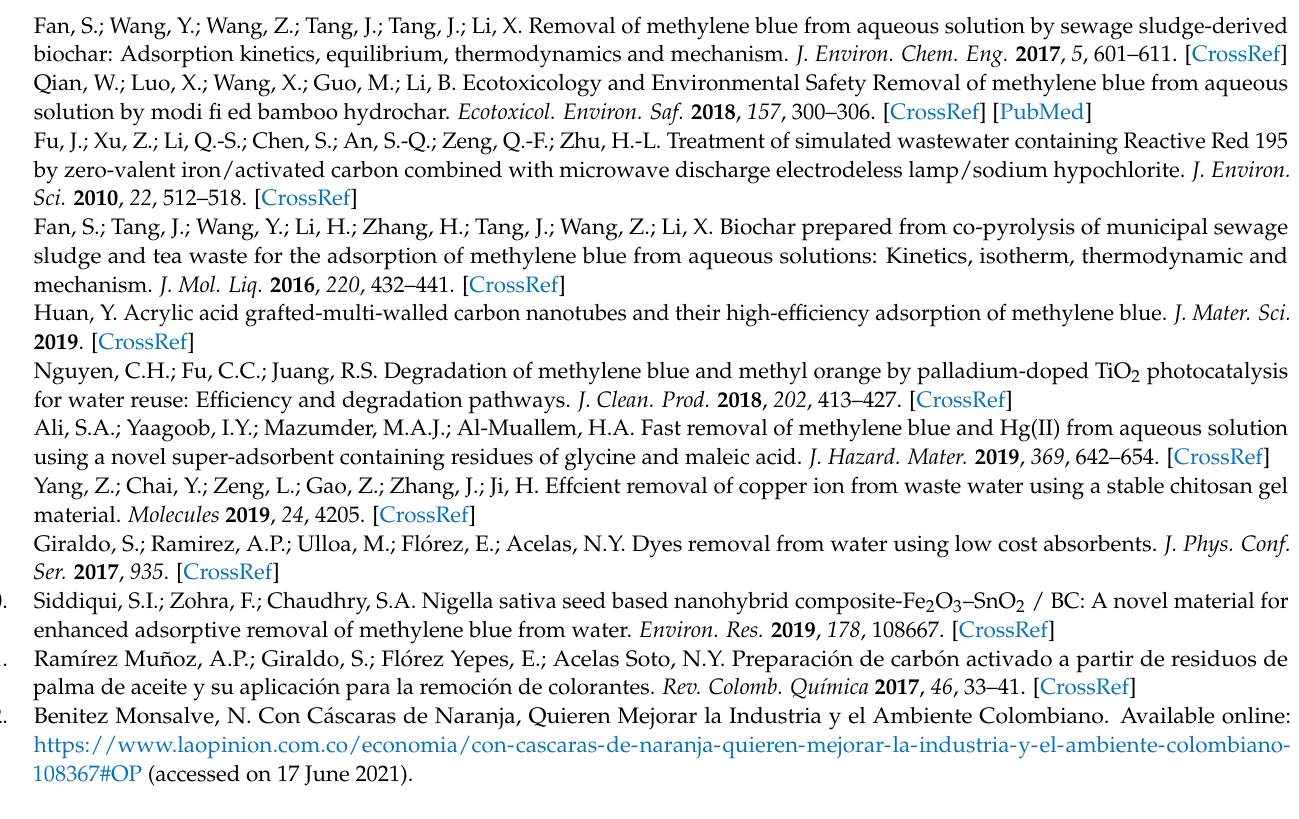
Supplementary Materials: The following are available online. Figure S1 FTIR spectra of calcined materials at different temperatures. Figure S2 pH PZC of adsorbent materials. A: OP; B: AZOP-550; C: AHOP. Figure S3 Graphs of the adsorbents (OP, AHOP and AZOP-550) for kinetic models with the equation (C0 50 mg L − 1 ). Figure S4 Graphs of the adsorbents (OP, AHOP and AZOP-550) for isotherm models with the equation. Table S1 Equation kinetic models. Table S2 Equations models isotherms. Table S3 Biomass analysis data. Table S4 Parameters for the different kinetic models for the adsorption of MB on OP, AZOP-550 and AHOP. Table S5. Total energy (Hartree) of all